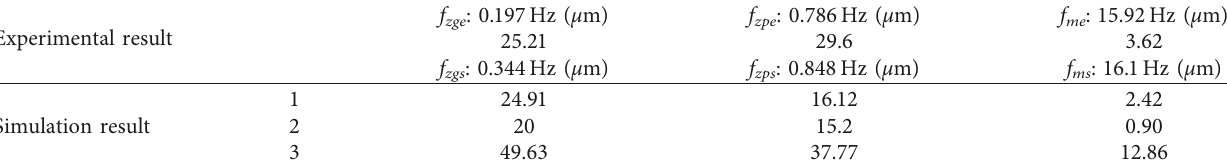
Table 4: The amplitudes corresponding to the fundamental frequencies in experimental and simulation results at 50.8rpm.